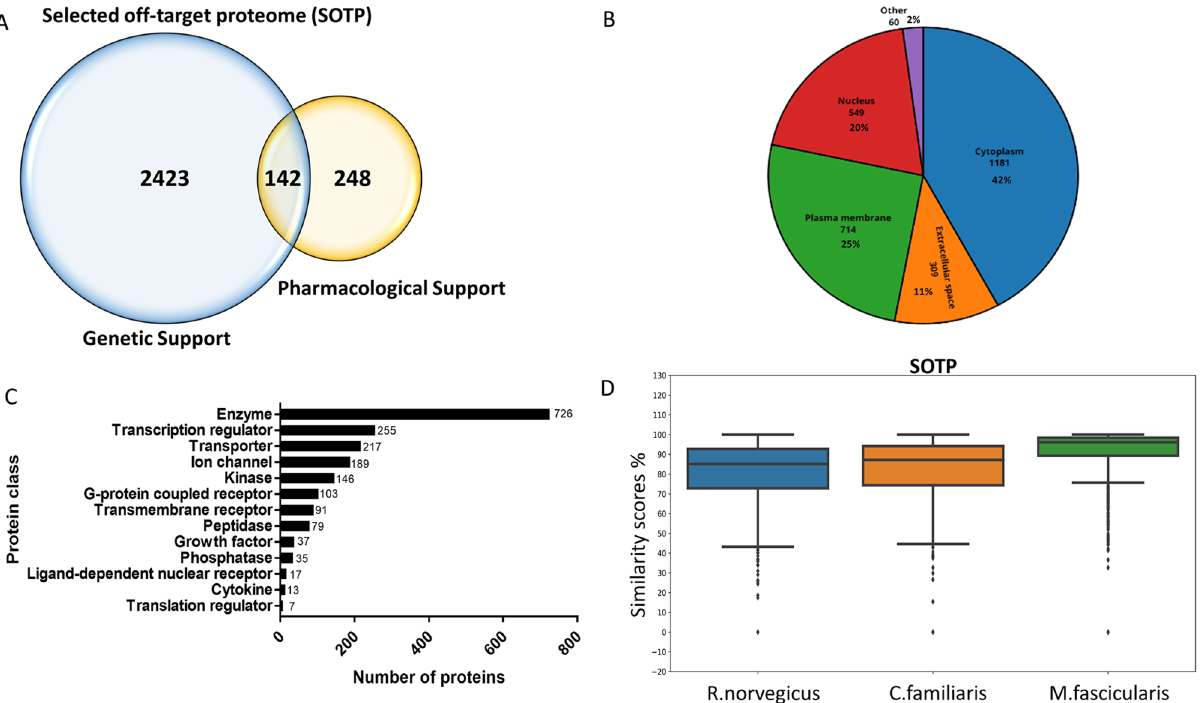
Figure 2. Systematic selection of SOTP and cell lines. ( A ) Venn diagram of SOTP composition. ( B ) Subcellular localization of SOTP. ( C ) Protein class of SOTP. ( D ) the similarity of primary protein structures between